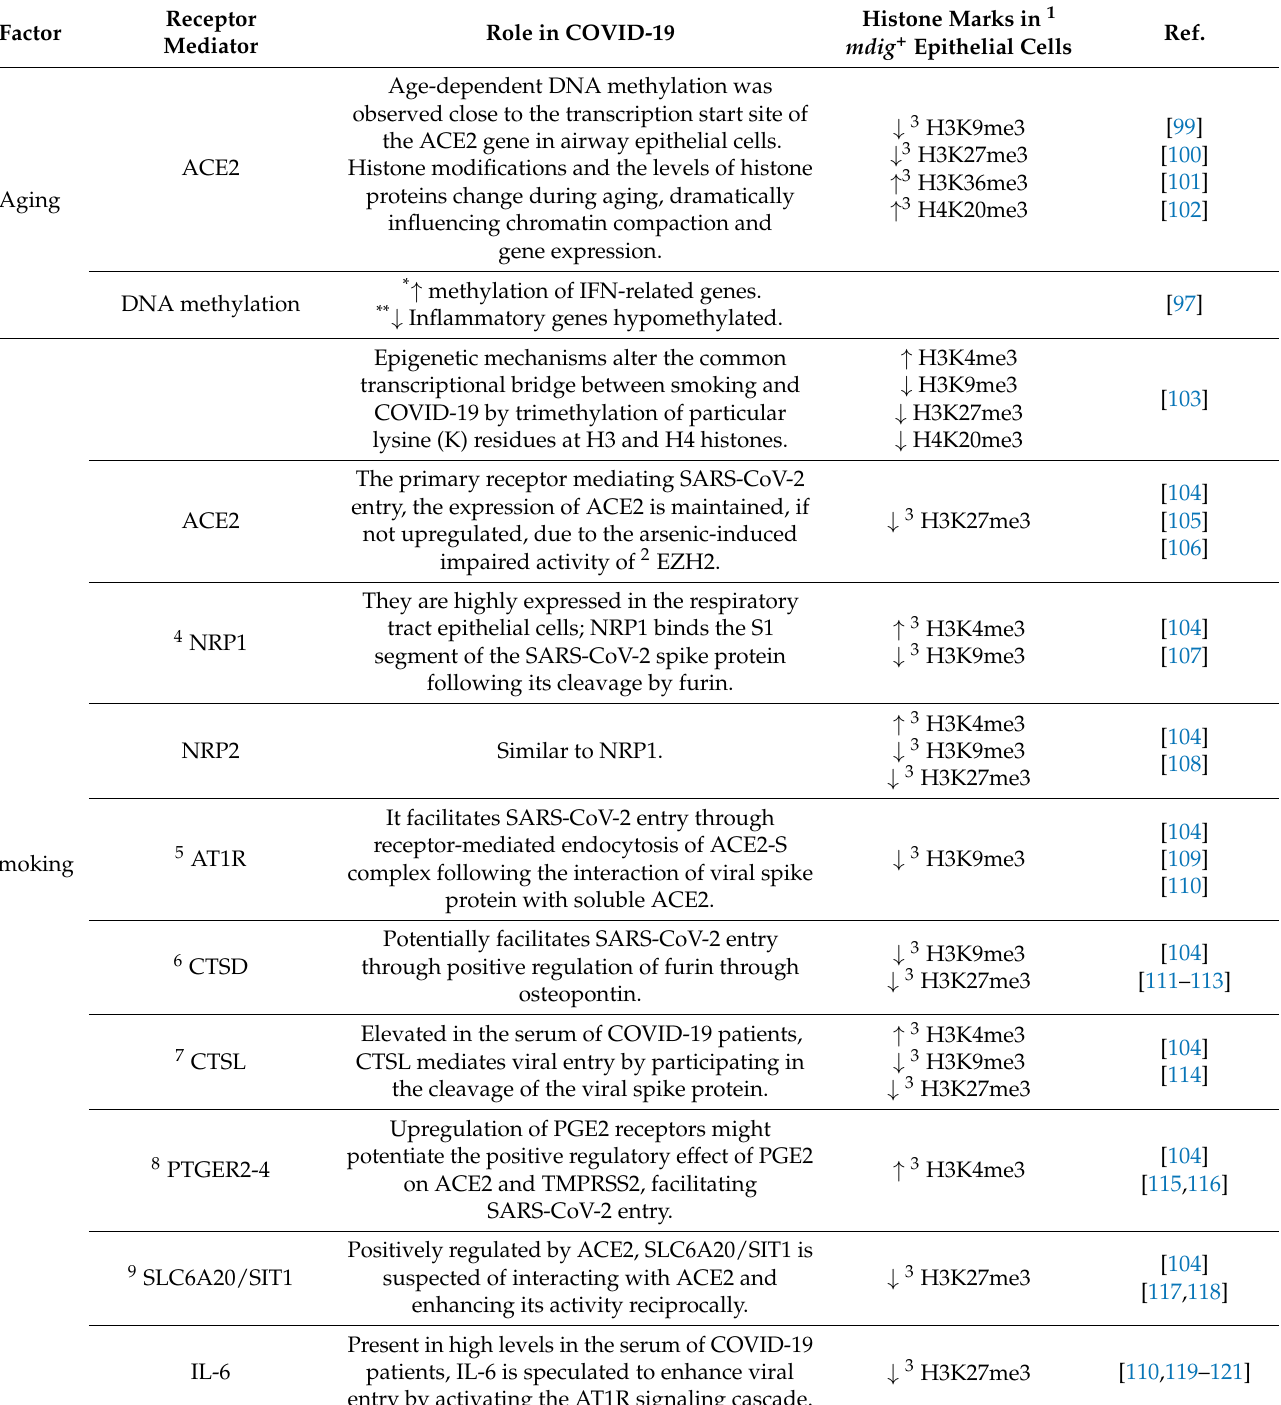
Table 2. Epigenetically upregulated receptors/mediators associated with SARS-CoV-2